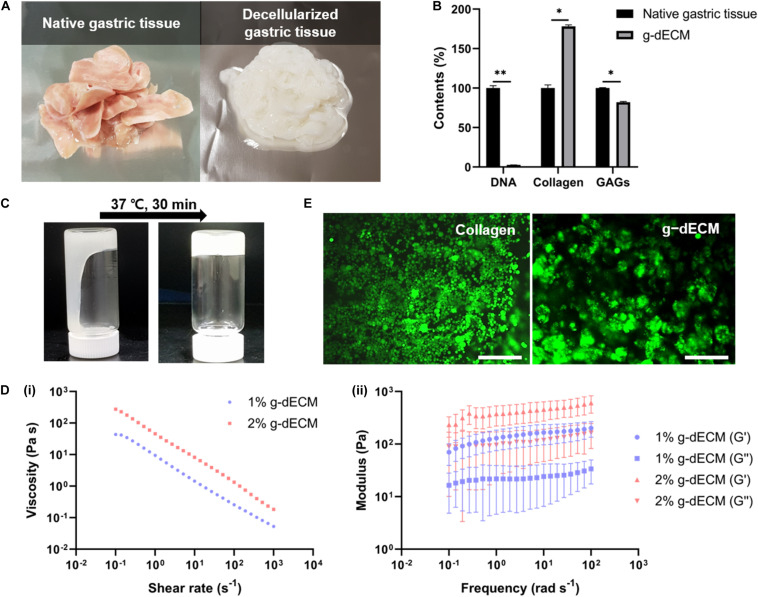
Preparation and characterization of g-dECM bioink. (A) Optical micrographs of sliced native gastric tissue and decellularized gastric tissue (g-dECM). (B) Comparison of the amount of extracellular components (collagen, GAGs) and DNA in native tissue and g-dECM. (C) Sol-gel transition of the g-dECM bioink. (D) Rheological properties of g-dECM bioink: (i) viscosity at 15°C (ii) dynamic modulus at 37°C. (E) Live/dead evaluation of human gastric cancer cell-line (AGS) on day 14 (scale, 200 μm, *p < 0.05, **p < 0.01).